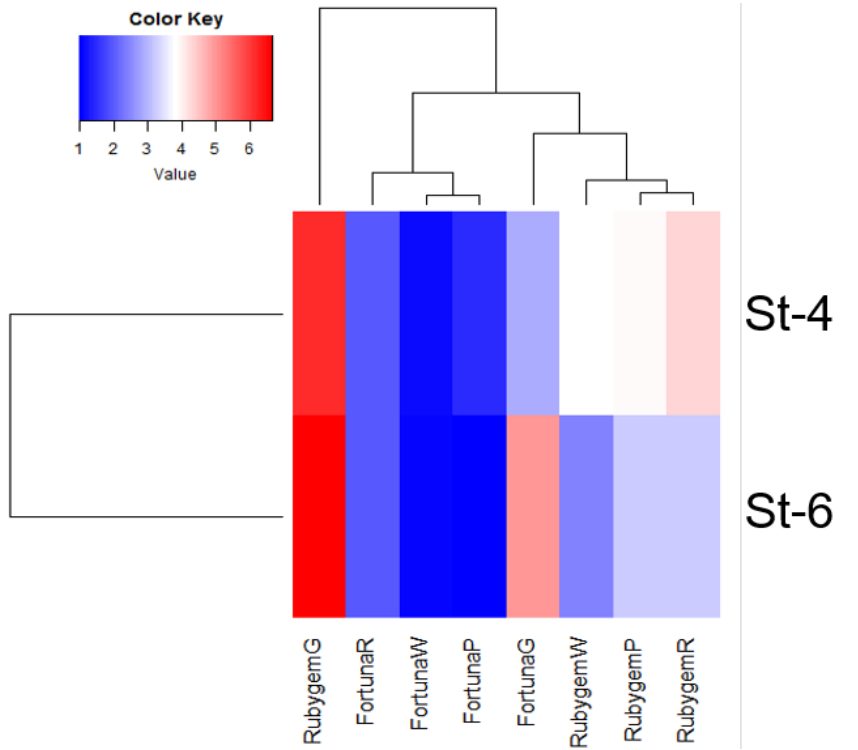
Figure 4. The heatmap of expressed genes related to invertase activity in four different fruit devel- opment stages in two strawberry varieties. ment stages in two strawberry